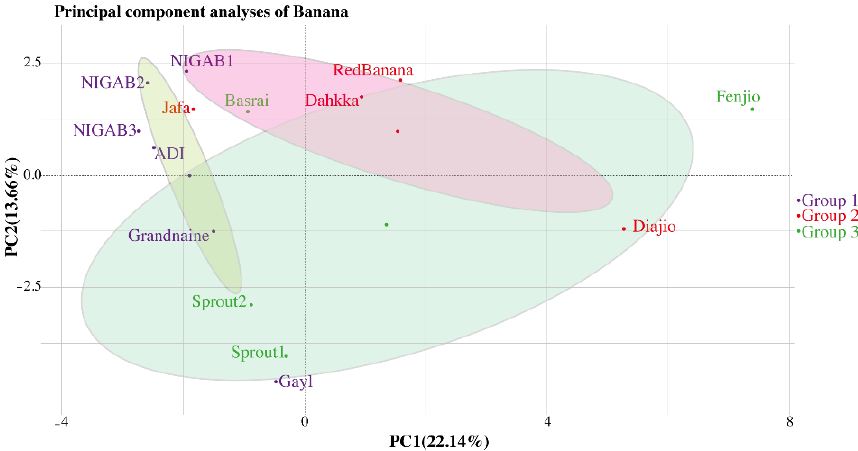
Figure 2. Bi-plot of Principal Component Analysis of three groups of banana varieties showing PC1 contributing 22.14% variation and PC2 13.66% variation. Fenjiao and Dajiao are the most diverse line as compared with the other two groups. Table 2. Principal Component Analysis (PCA), bi-plot, and varieties of the structure of three genomic constitutions of Banana varieties as revealed by ISSR